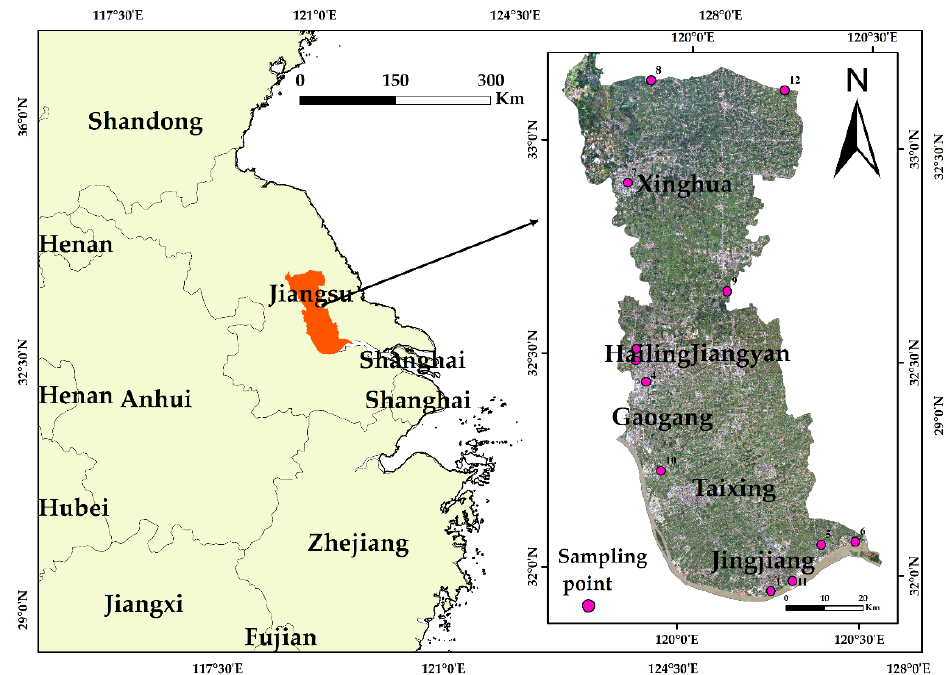
Figure 1. Study area and location of sampling points.